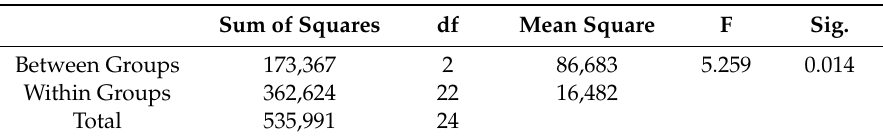
Figure 12. Means Plots. Table 7. One way ANOVA